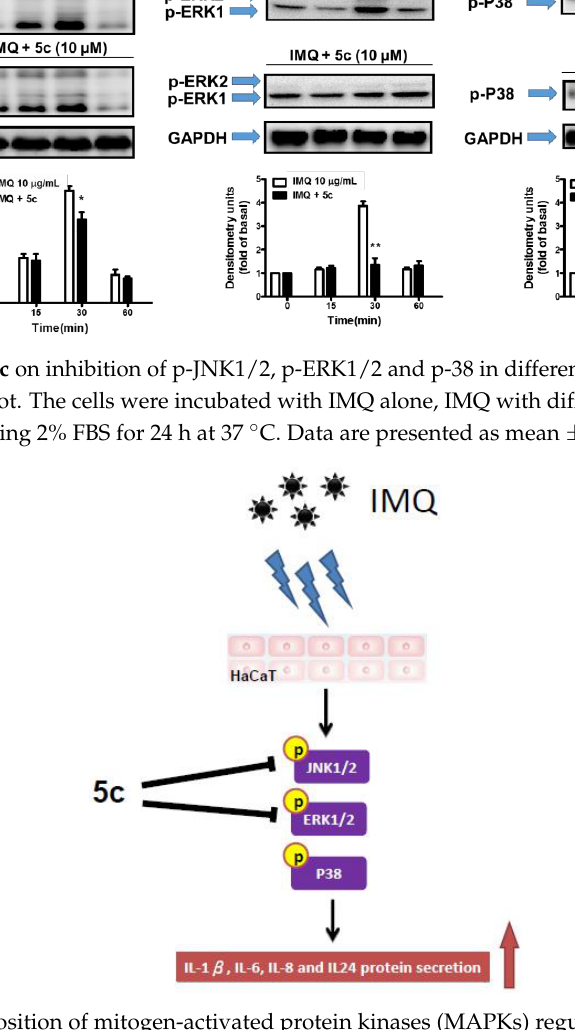
Figure 6. The supposition of mitogen-activated protein kinases (MAPKs) regulated proinflammatory pathways in psoriasis.